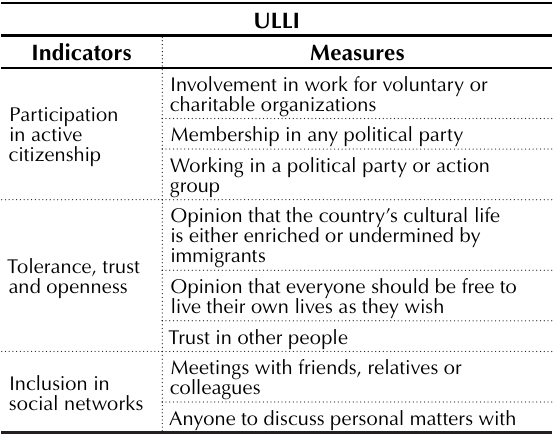
Table 4. The adapted dimension of learning to live together